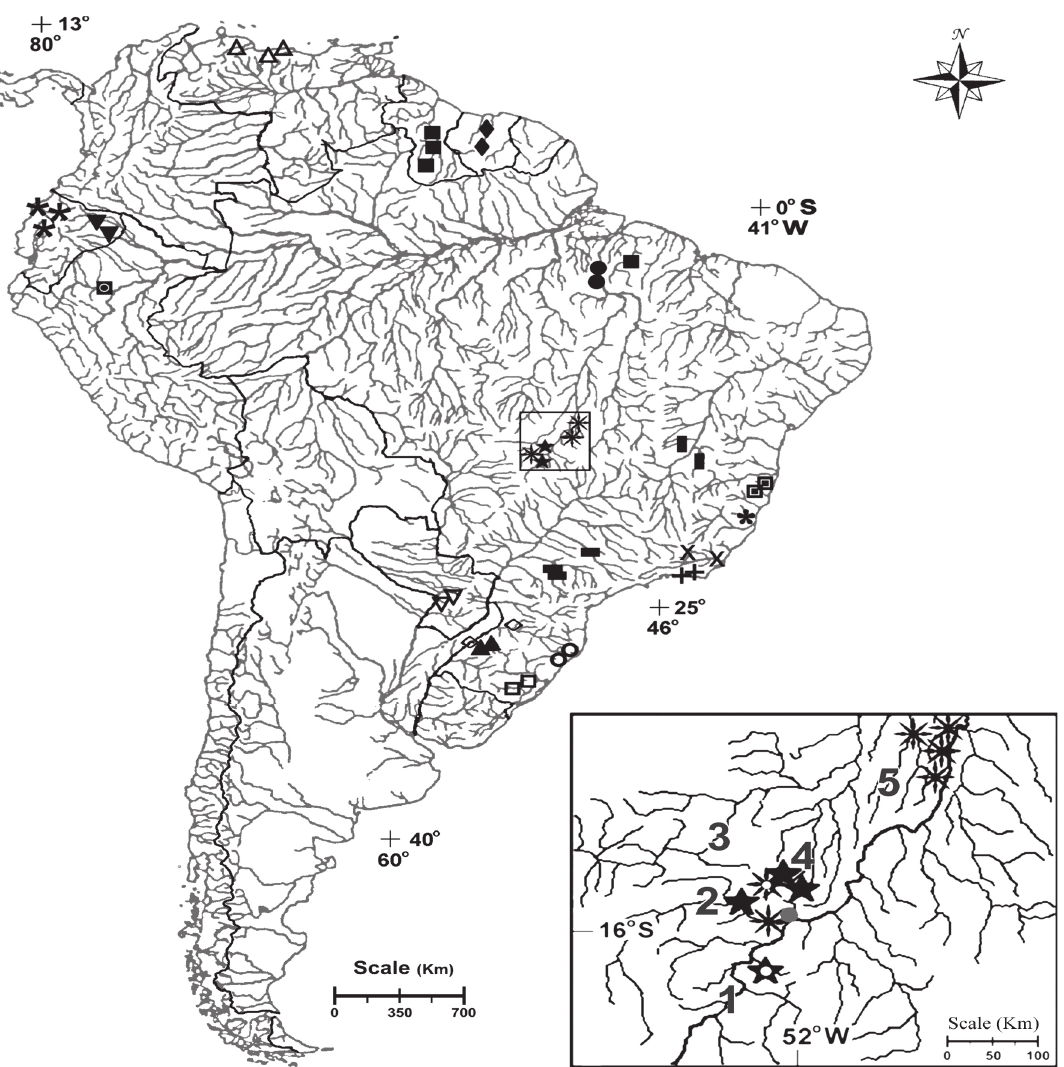
Fig. 4. Map of South America showing the distribution of species of Microglanis , with the exception of M. ater , whose type locality was originally cited as “Mittelbrazil”. Microglanis carlae (open inverted triangle), M. cibelae (open circle), M. cottoides (open square), M. eurystoma (open diamond), M. garavelloi (solid horizontal rectangle), M. iheringi (open triangle), M. leptostriatus (solid vertical rectangle), M. malabarbai (solid triangle), Microglanis minutus (clover), M. nigripinnis (cross), M. oliveirai (spiny dot), M. parahybae (X), M. pataxo (solid square inside open square), M. pellopterygius (solid inverted triangle), M. poecilus (solid square), M. robustus (solid circle), M. secundus (solid diamond), M. variegatus (asterisk), M. xylographicus (star), and M. zonatus (solid circle inside solid square). Upper rio Araguaia basin area in inset: 1, rio Araguaia; 2, rio das Garças; 3, rio das Mortes; 4, rio Corrente; 5, rio Cristalino. Gray point indicates the city of Barra do Garças, Mato Grosso State. Star with white point indicates the type-locality of Microglanis xylographicus . Spiny dot with white point indicates the type-locality of Microglanis oliveirai